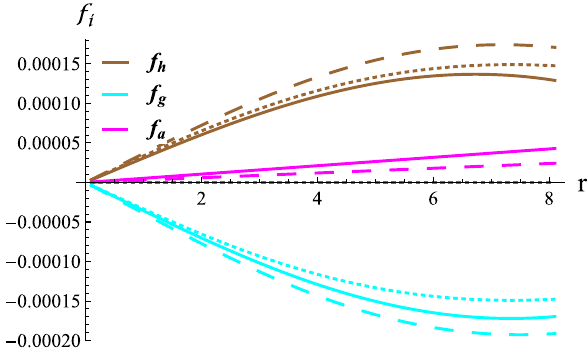
Fig. 3 Plots of hydrostatic equilibrium with χ = 0 ( dotted ) , 0 . 04 ( dashed ) , 0 . 06 ( solid ) for solution I